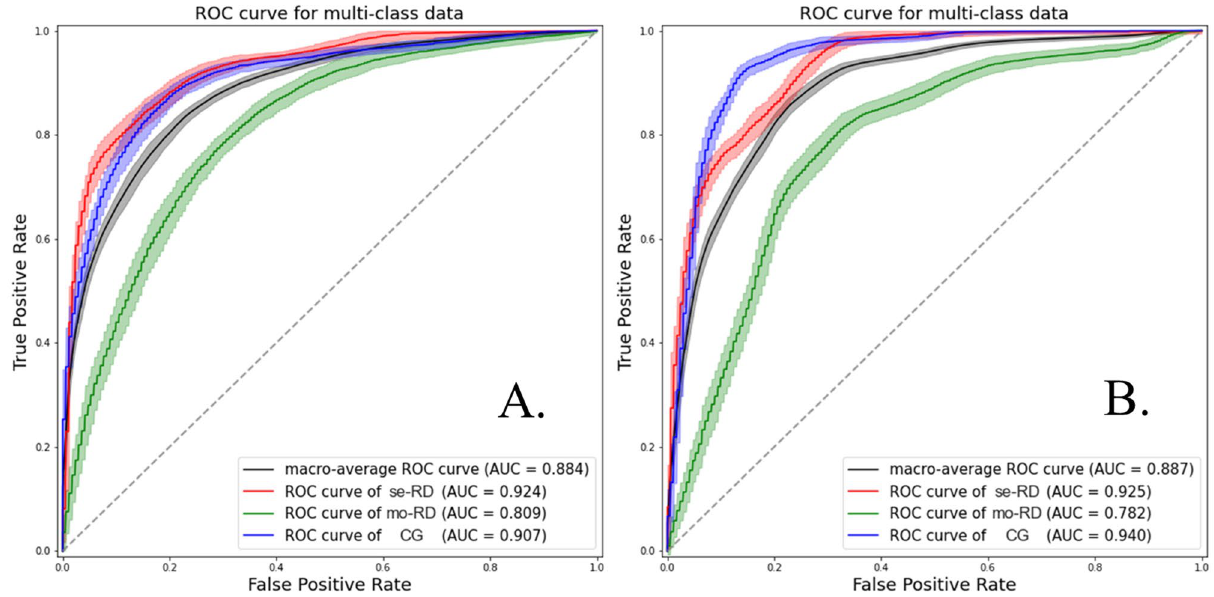
Figure 1. The receiver operating characteristic (ROC) curves and area under the curve (AUC) values of representative classification models using T1-weighted water-only images with a random forest classifier ( A ) and all T1-weighted images using a support vector machine with rbf kernel classifier ( B ) in classifying the three groups of chronic kidney disease. Severe renal dysfunction group (se-RD, estimated glomerular filtration rate [eGFR] < 30 mL/min/1.73 m 2 ), moderate renal dysfunction group (mo-RD, 30 ≤ eGFR < 60 mL/min/1.73 m 2 ), and control group (CG, eGFR ≥ 60 mL/min/1.73 m 2 ). The AUC values are expressed as means.